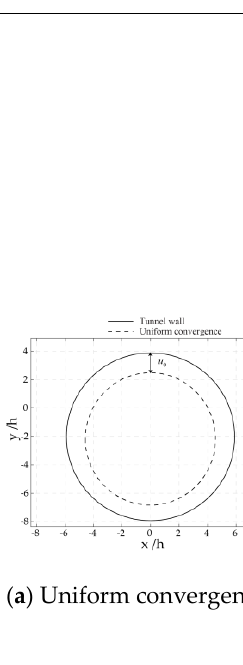
Figure 7. Displacement induced by uniform convergence.